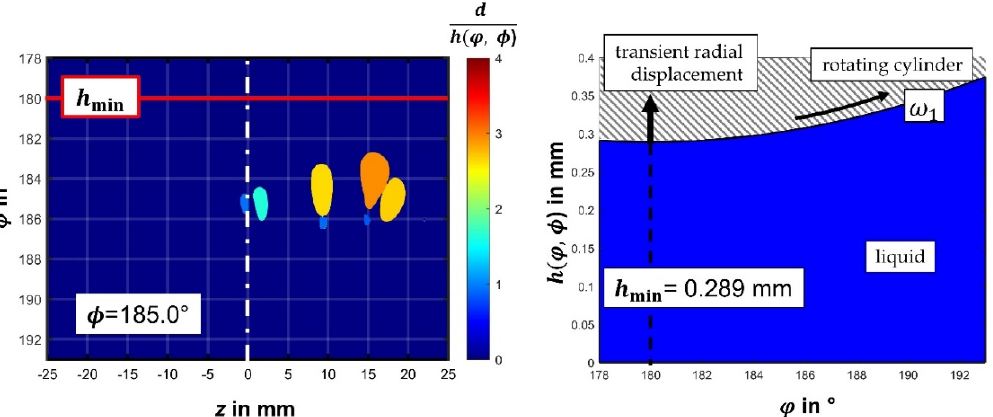
Figure 10. Bubble size in relation to local film thickness during phase 3—final stage of bubble increase, rotational angle φ = 186.3 ◦ after initiation of transient radial displacement, solely pseudo-cavitation, fluid: paraffin containing 100% dissolved air.